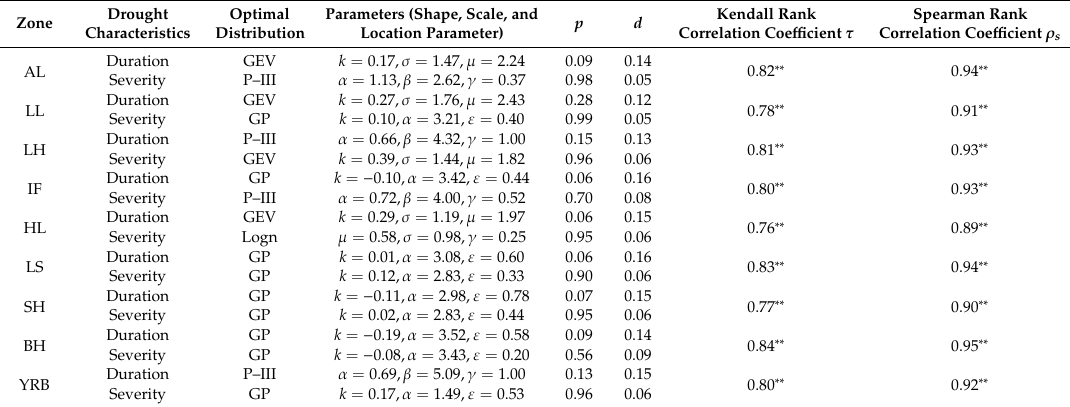
Table 3. Determination of the optimal marginal distribution